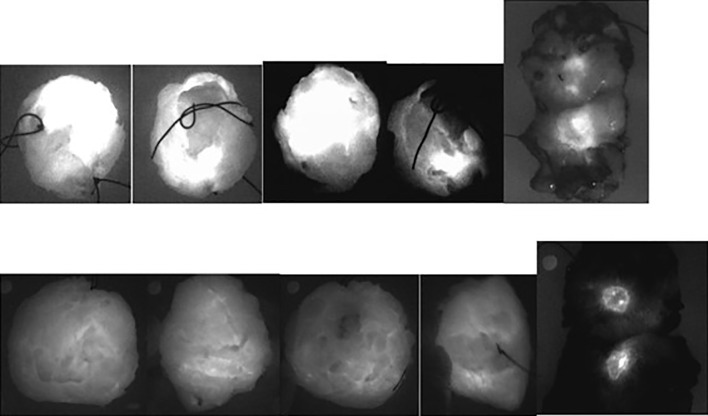

Ex vivo NIR fluorescence imagings of lumpectomy specimens (in the operating room) and of their slicings (in the department of Pathology) obtained: Upper panel: in patient n° 5 of Group 3 with a lobular invasive carcinoma, 19 × 10 × 11 mm large, close to the posterior margin (<1 mm) and to the anterior margin (4 mm) within a tumorectomy specimen sized 35 mm × 27 mm × 20 mm, histologically graded 1, with a maximum tumor to background fluorescence ratio equal to 2.0: the corresponding views of the whole specimen showed clear fluorescence at the surface of the specimen- Lower panel: in patient n° 6 of Group 3 with a canalar invasive carcinoma, 14 mm large within a tumorectomy specimen sized 62 mm × 75 mm × 35 mm, histologically graded 2 and with a maximum tumor to background fluorescence ratio equal to 4.0: the tumor was well centered and the corresponding views of the whole specimen showed no clear fluorescence at the surface of the specimen.